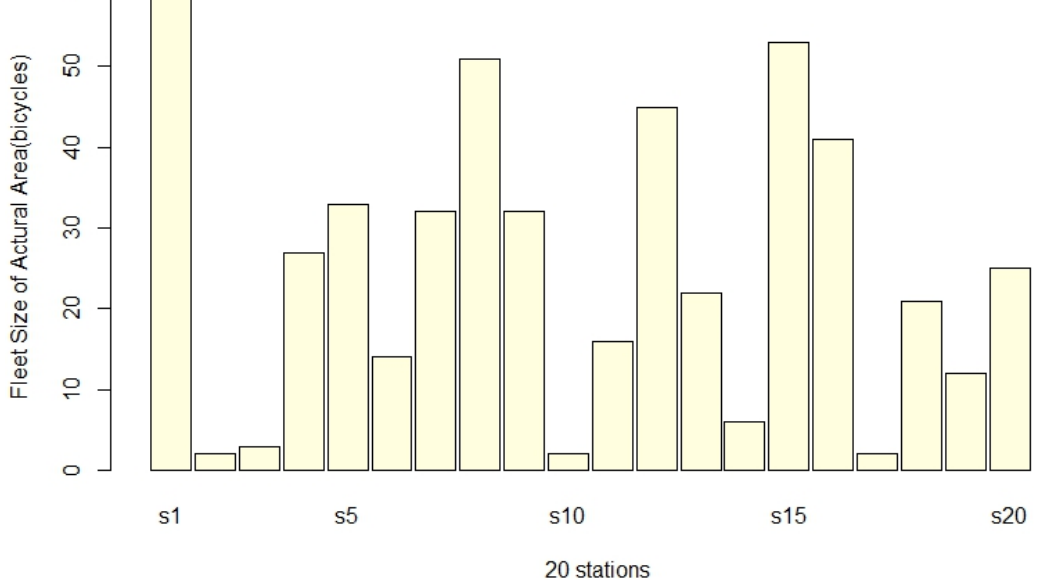
Figure 6. Statistical diagram of actual fleet size vector for dockless bike-sharing stations.